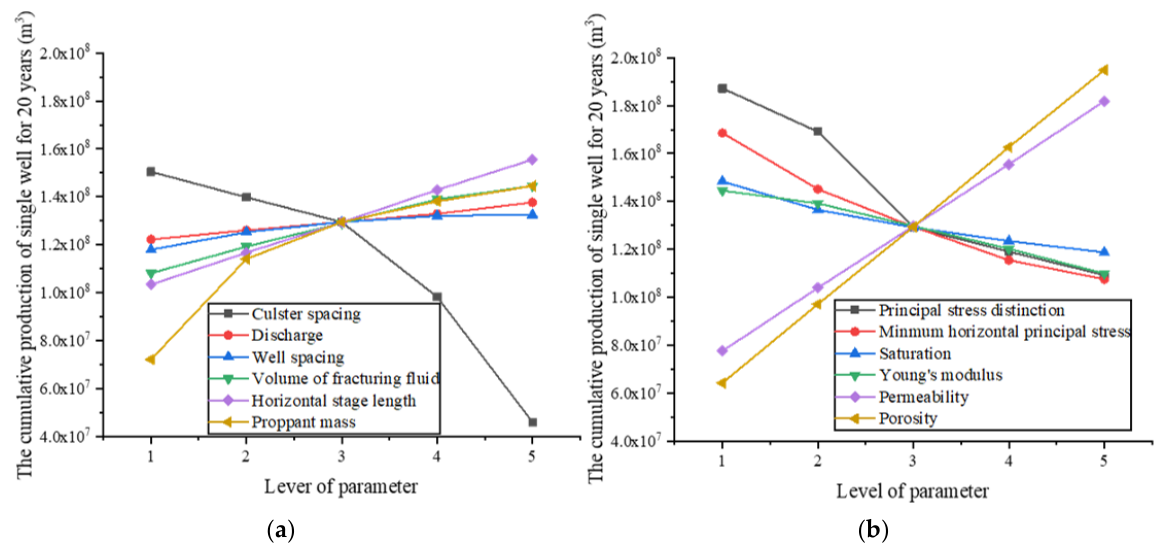
Figure 4. The change in cumulative production with the level of parameter in different factors: ( a ) engineering factors; ( b ) geological factors.